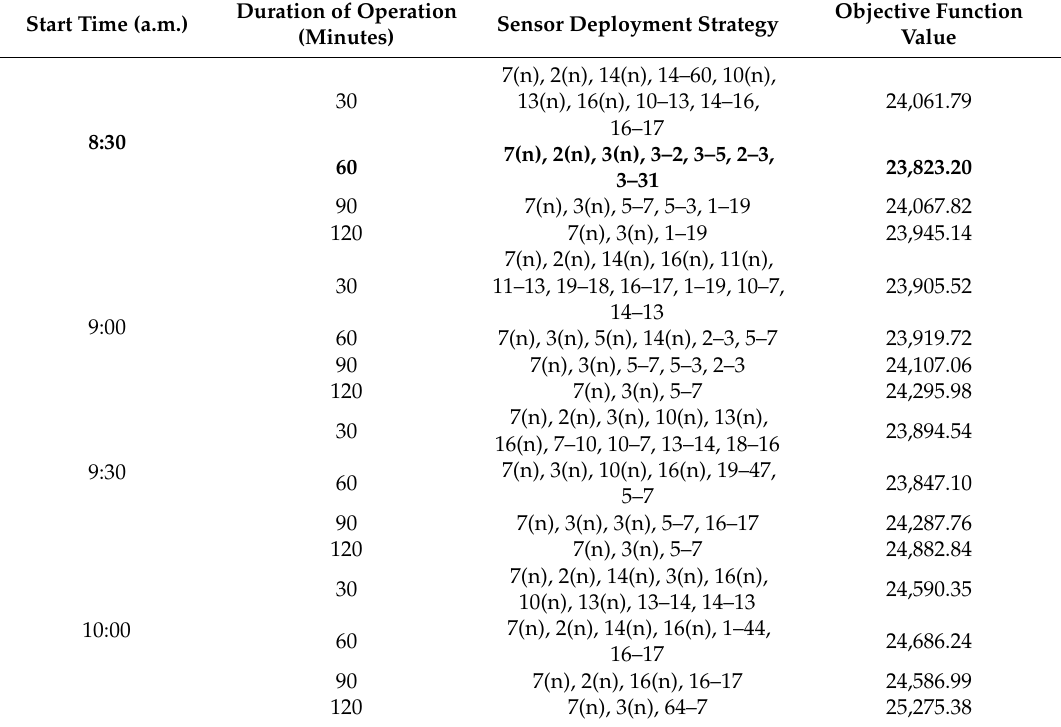
Table 1. Sensor Deployment Strategies with different start time and duration of operation for which traffic data measurements are